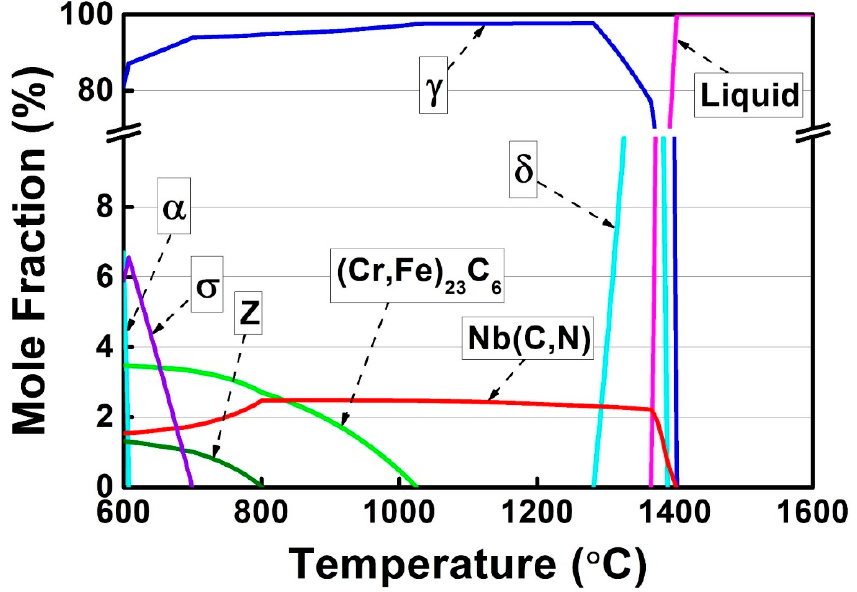
Figure 2. Phase diagram of alloy 3C2N calculated by JMatPro software under the equilibrium condition.